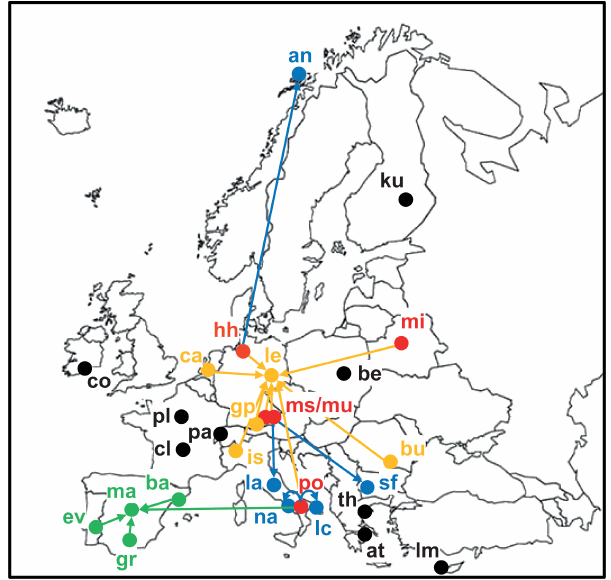
Figure 1. Map of EARLINET and stations involved in the inter- comparison campaigns (station IDs: an – Andenes, at – Athens, ba – Barcelona, be – Belsk, bu – Bucharest, ca – Cabauw, cl – Clermont-